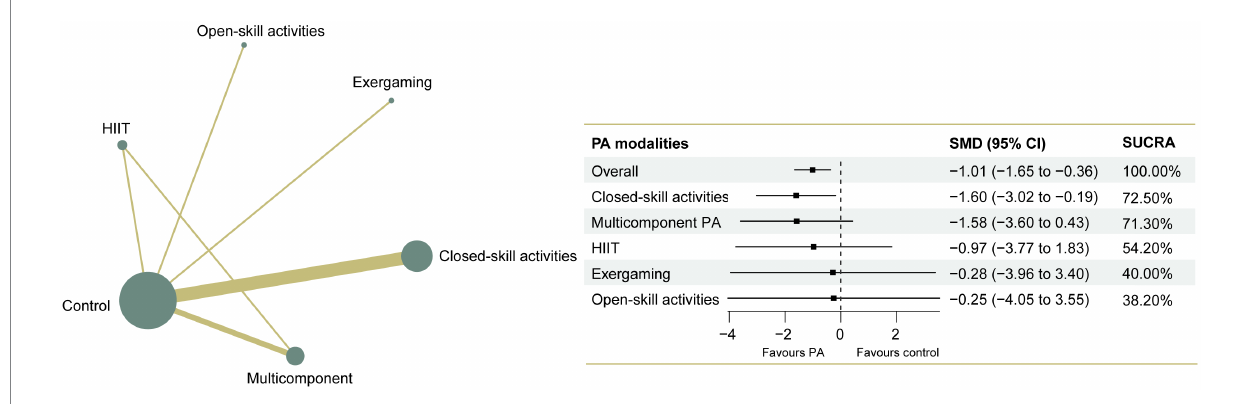
FIGURE 4 Network plot of comparisons and the efficacy of various treatments compared with the control group for hyperactivity/impulsivity. Each node represents an intervention and its size depends on the number of participants. The connecting lines between 2 nodes represents 1 or more trials in which the 2 interventions have been compared directly. The thickness of the lines connecting 2 nodes is weighted according to the number of trials that directly compared the interventions it connected. PA, physical activity; SMD, standardized mean difference; SUCRA, the surface under the cumulative ranking